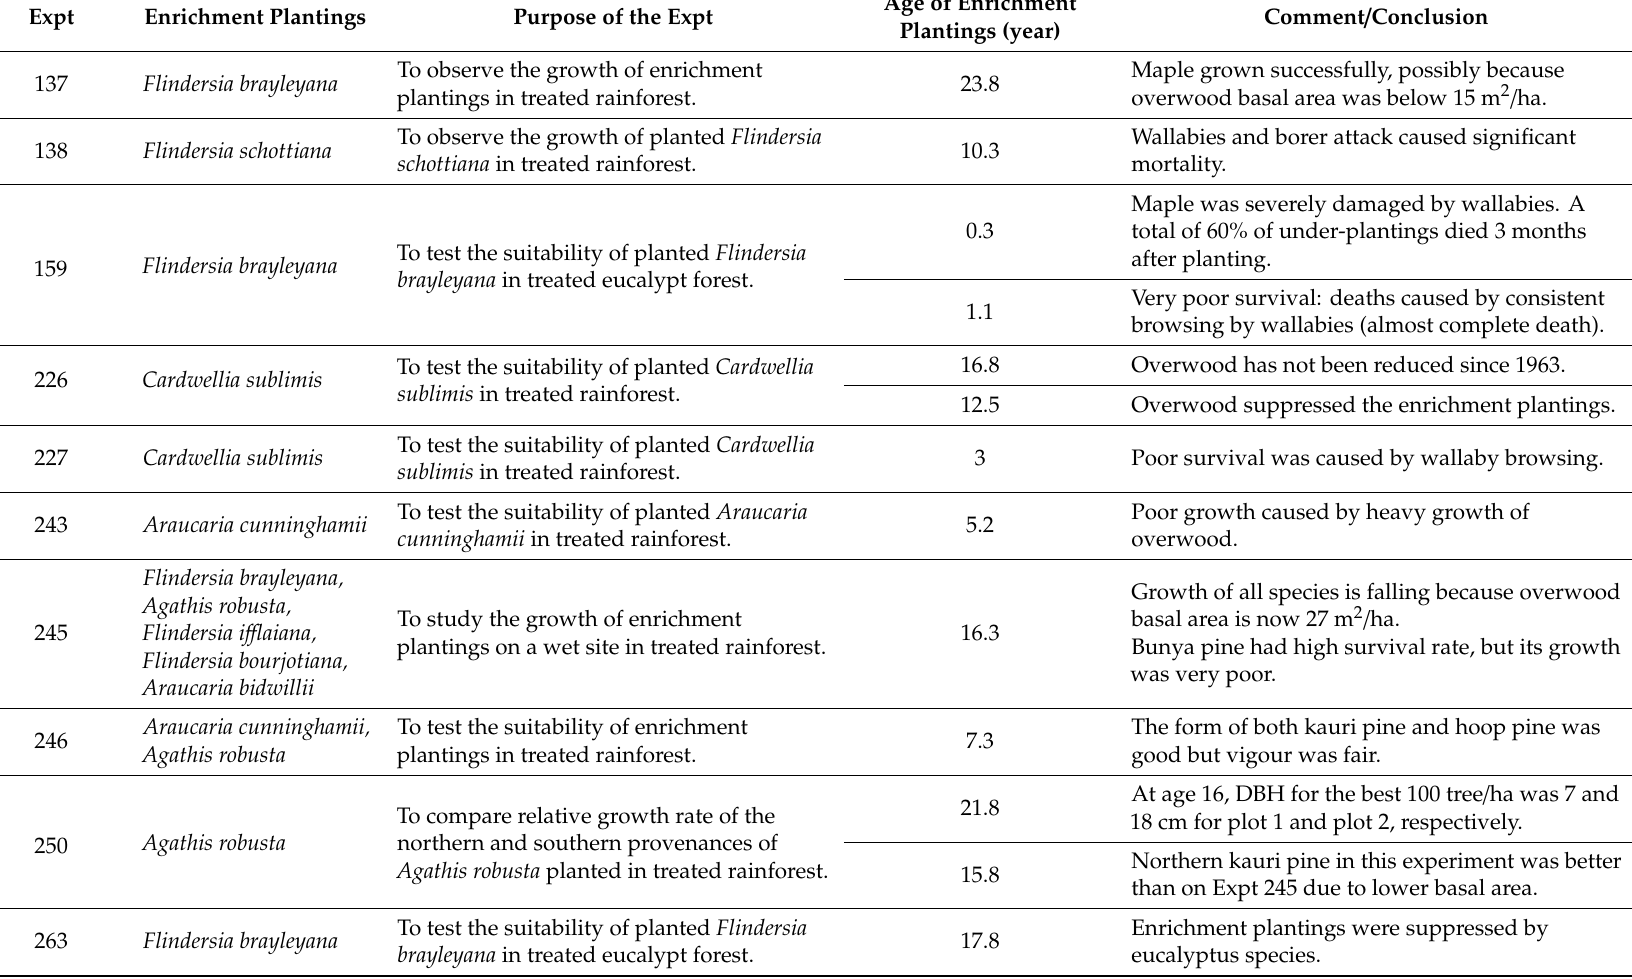
Table A4. Summarized qualitative comments extracted from historical records of enrichment planting experiments in north